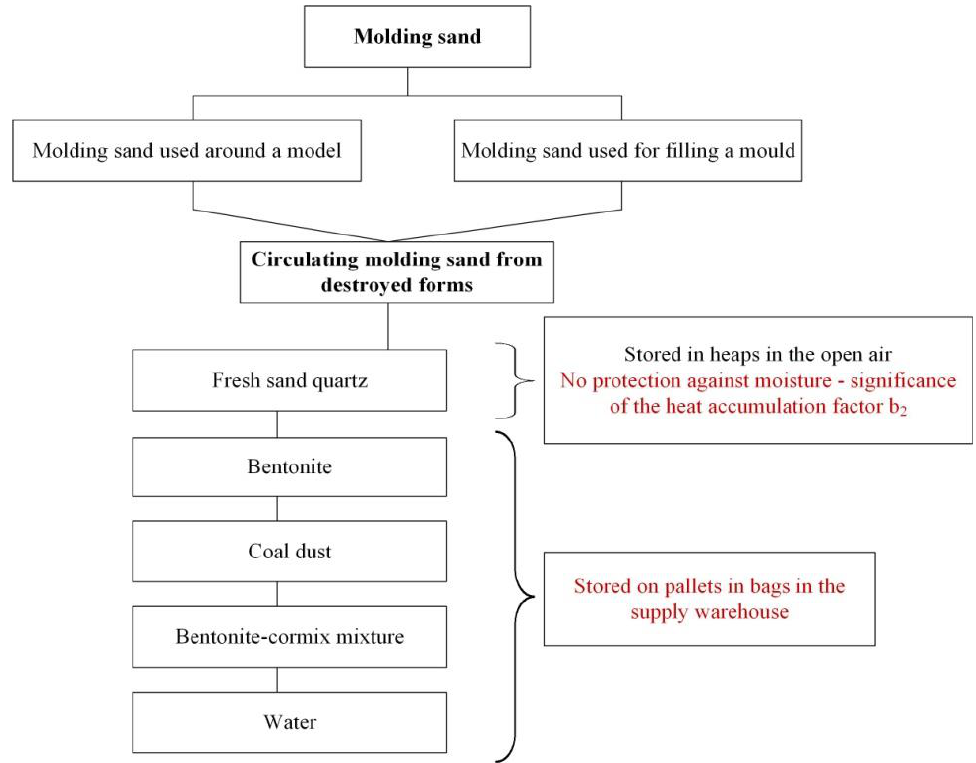
Figure 3. Diagram of the composition and the storage method of molding sand.